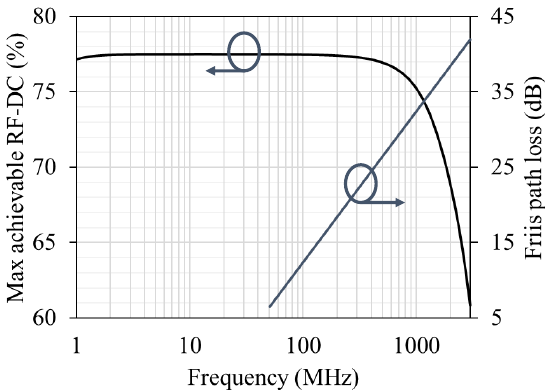
Figure 2. Maximum achievable RF-DC efficiency simulated using non-linear harmonic balance, and the propagation losses (Friis model at 1 m) over